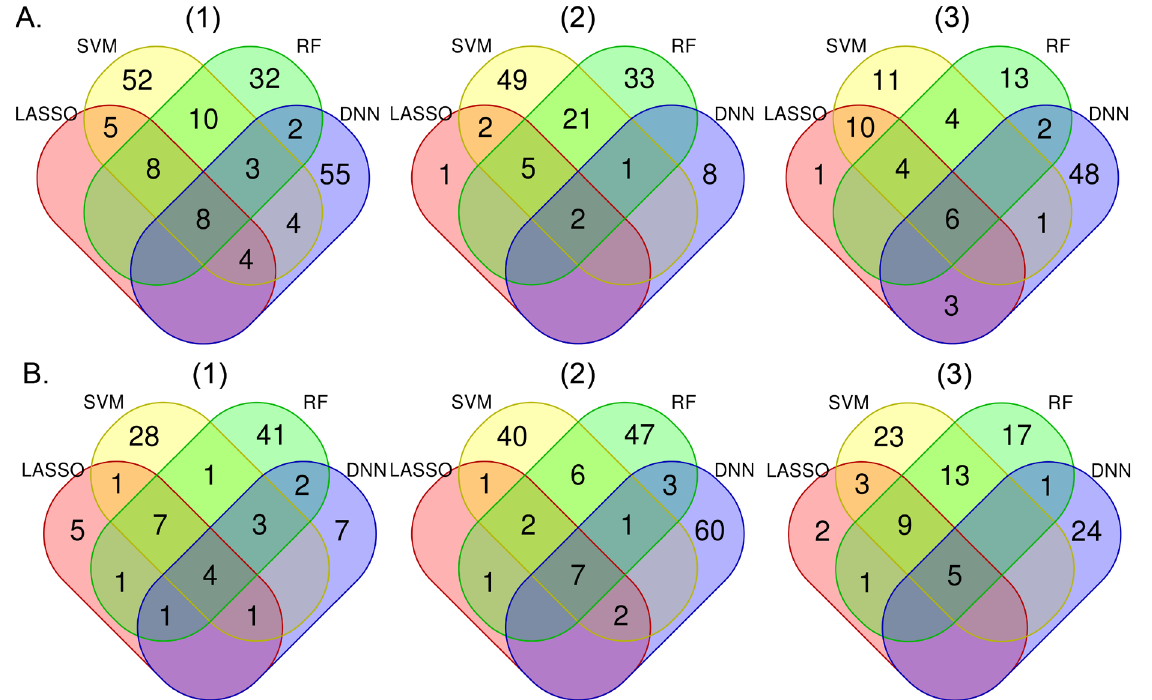
Figure 1. Number of overlapping “high impact” variables selected by each machine learning method based on the importance measurement in African Americans (A) and European Americans (B) for models (1), (2), and (3). Model 1 includes all variables except for those that are confounded with opioid cessation. Model 2 includes all variables in Model 1 except opioid-related variables. Model 3 includes all variables in Model 2 except drug use-related variables. Colors represent particular machine learning methods: pink = LASSO, light yellow = SVM, light green = RF, light blue =